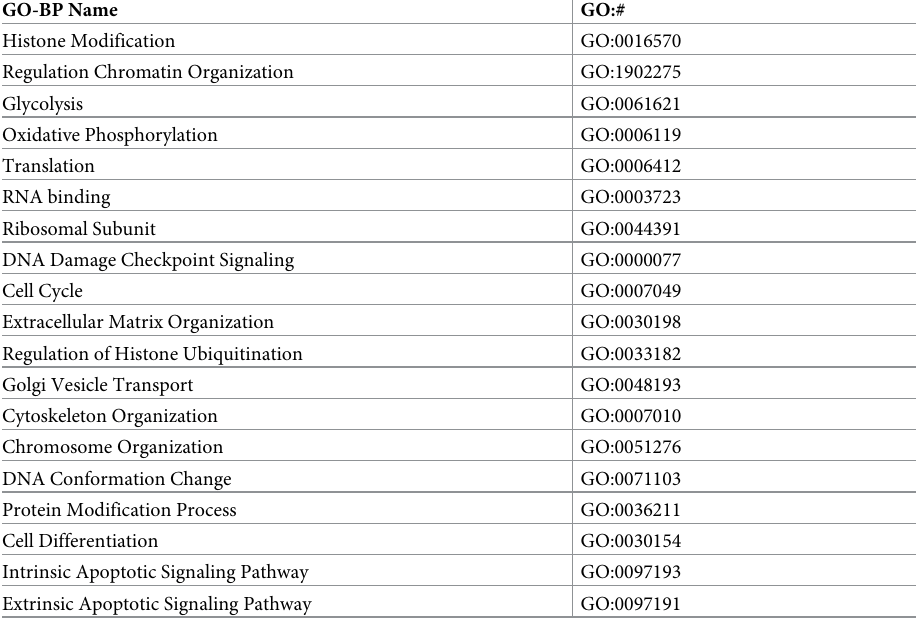
Table 3. GO Biological Process Gene